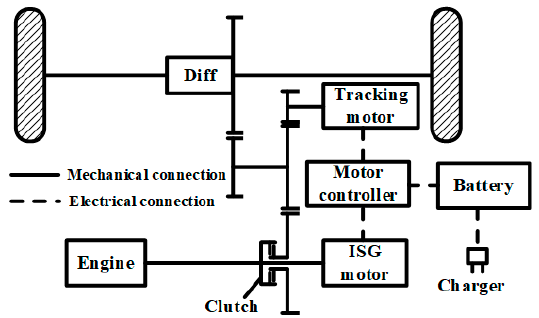
Figure 1. Configuration of a series-parallel plug-in hybrid electric vehicles (PHEV) power system. The values of the key parameters of the hybrid system are given in Table 1. Table 1. Key parameters of series-parallel PHEV power system .